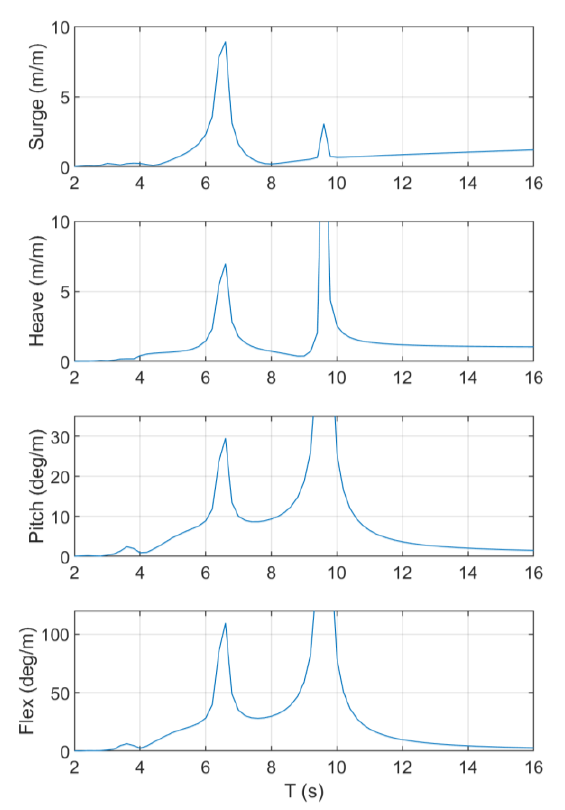
Fig. 6. Frequency-domain undamped response RAO